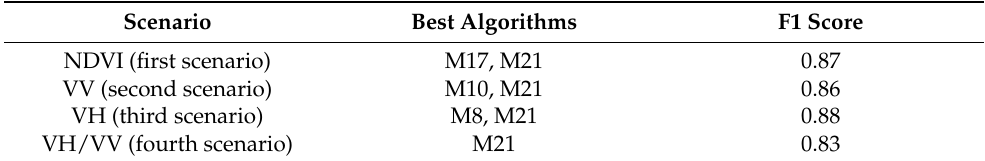
Table 4. Best performing algorithms in the first approach for each scenario and their F1 scores.